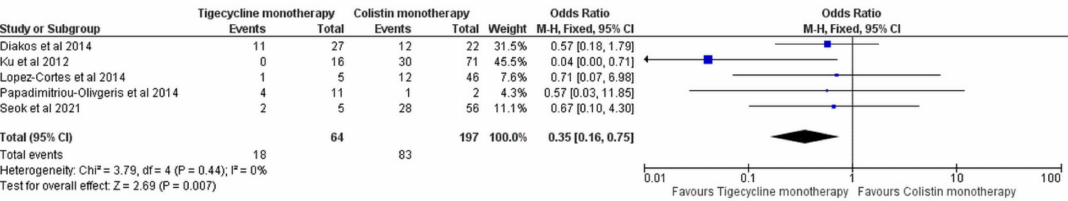
Figure 4. Thirty-day mortality of tigecycline monotherapy versus colistin monotherapy [7,14,15,17,24].